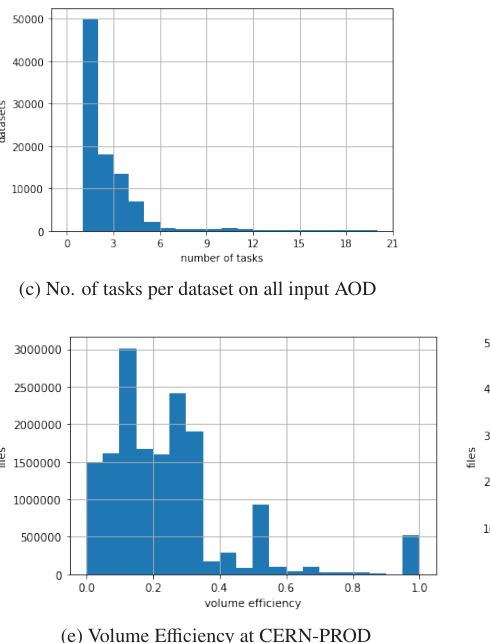
Figure 4: Accesses time locality